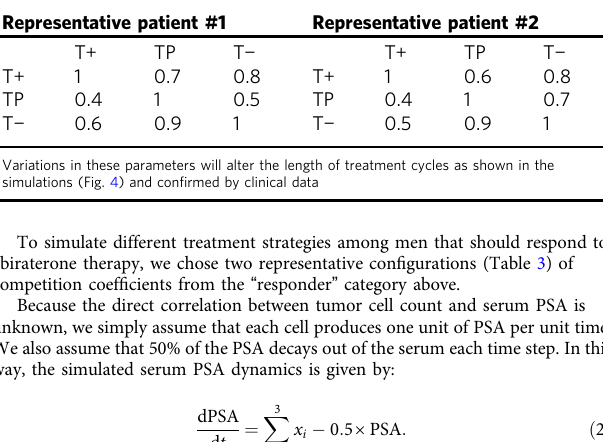
Table 3 Values of competition coef fi cients in representative patients responding to abiraterone therapy Representative patient